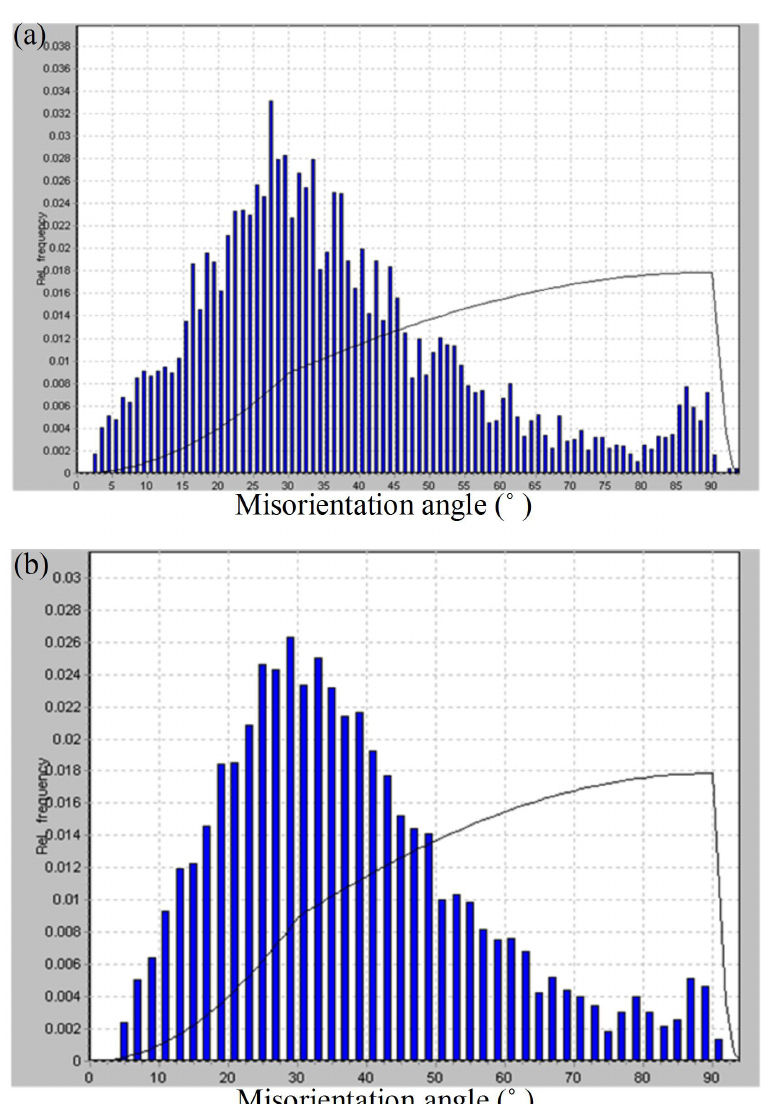
Fig. 8. Misorientation of the annealed AR sheets: (a) from ingot, and (b) from TRC.